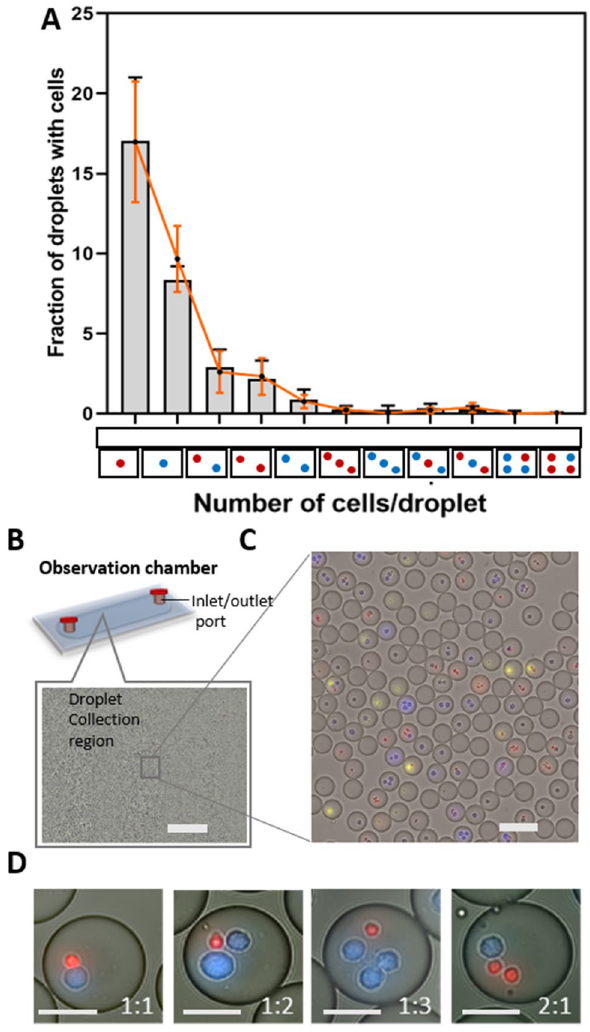
Figure 2. Cell encapsulation and pairing in droplets. ( A ) Graph showing the predicted fraction of droplets containing a different combination of cells illustrated on the x-axis according to Poisson distribution (red solid line) and the observed fraction of droplets containing given combinations of cells (bar diagram) at 7 million/ mL NK cells (red) and 10 million/mL K562 cells (blue); n = 3 independent experiments; red and black dots represents mean value for given combination for Poisson distribution and observed distribution respectively. Error bars represents standard error of mean. ( B ) Schematic and Macroscopic view of the observation chamber. The image represents around 229 mm 2 viewing area of the chamber, allowing to image ~ 100,000 droplets of 70 pL volume; scale bar = 1 mm. Droplets without cells are not shown in the figure. ( C ) Magnified segment in the observation chamber showing distribution of different cells in droplets; scale bar = 100 µm. ( D ) Visualization of different E:T ratios in droplets at the cell seeding concentration of 7 million/mL and 10 million/mL for effector and target cells, respectively; scale bar = 25